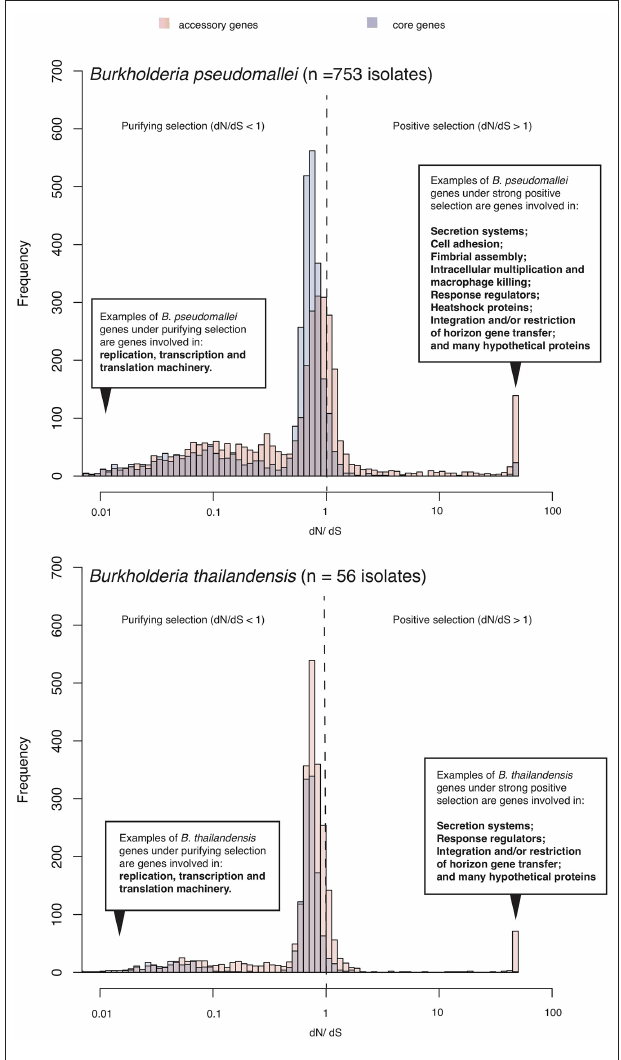
FIGURE 1 | Selection pressure acting on B. pseudomallei population. The histogram summarizes ranges of dN/dS calculated from predicted coding sequences from a collection of diverse B. pseudomallei population from northeast Thailand (Chewapreecha et al., 2019), and B. thailandensis genomes from the public database. B. pseudomallei and B. thailandensis have highly plastic genomes comprising of at least two chromosomes of ∼ 7–8Mb in size when combined. Using a pan-genome approach, all coding sequences could be categorized as “core” (present in all genomes) or “accessory” (variably present across studied genomes). Accessory genes display an elevated level of dN/dS which is signatures of positive selection or more relaxed purifying